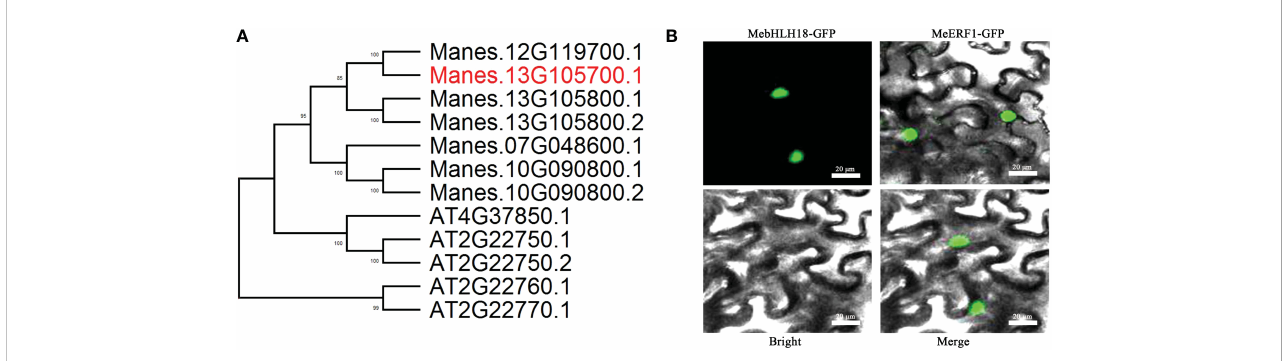
FIGURE 3 Functional characterization of MebHLH18. (A) Phylogenetic comparison of group indicated in Figure S1 (marked in red) bHLH members in cassava and Arabidopsis . Bootstrap values from 500 resamplings are indicated. (B) Subcellular localization of MebHLH18 . Transient expression of 35S: MebHLH18-GFP and 35S: MeERF1-GFP in Nicotiana benthamiana leaves is shown. MeERF1-GFP was used as a nuclear marker. Bars, 20 m